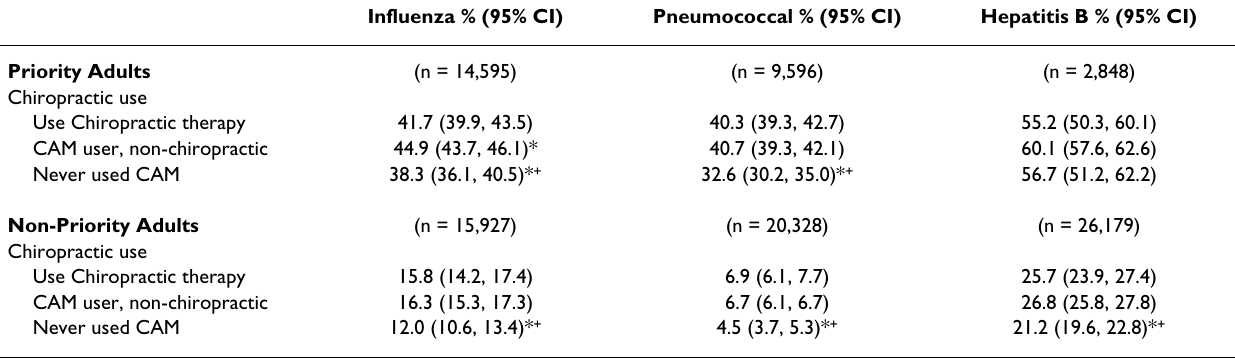
Table 4: Adjusted a vaccination coverage levels of priority and non-priority adults by Chiropractic therapy use, 2002 National Health Interview